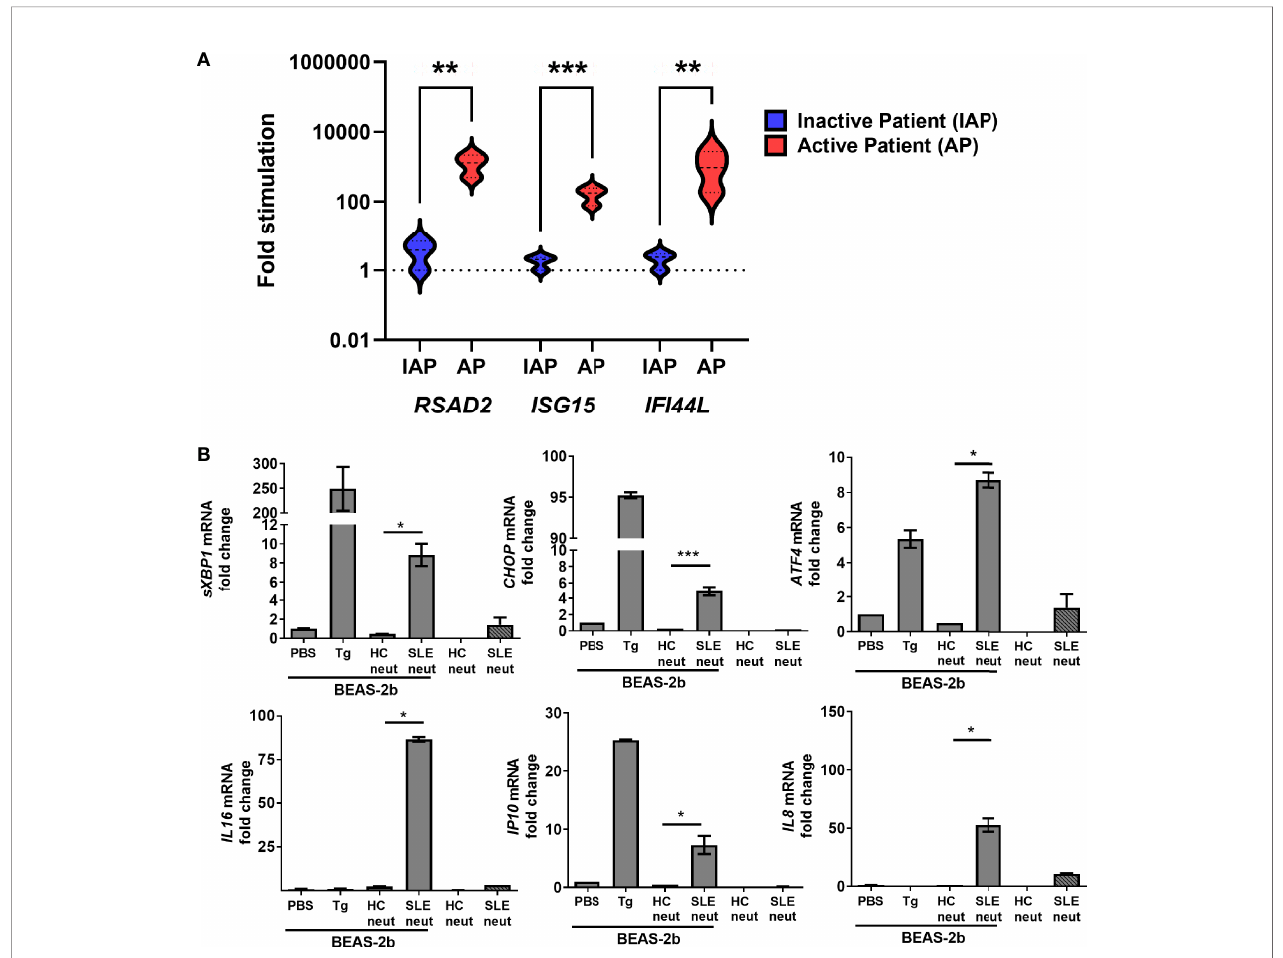
FIGURE 4 | Active SLE patient neutrophils are in fl ammatory and induce ER stress in human BEAS-2b bronchial epithelial cells. (A) The expression levels of ISGs in neutrophils isolated from the whole blood of inactive SLE (IAP) or moderate to active SLE patients (SLEDAI > 4, AP) as determined by qPCR (n=3 for each group). (B) Neutrophils from healthy control and active SLE patient (n=3 per group) whole blood were isolated and cultured alone or directly with BEAS-2b cells at a 1:4 ratio and incubated overnight. The expression levels of ER stress genes were determined by qPCR of whole cells. Values are the mean ± SD. Statistical signi fi cance was determined by one-way ANOVA test. * p < 0.05, ** p < 0.01, and *** p ≤